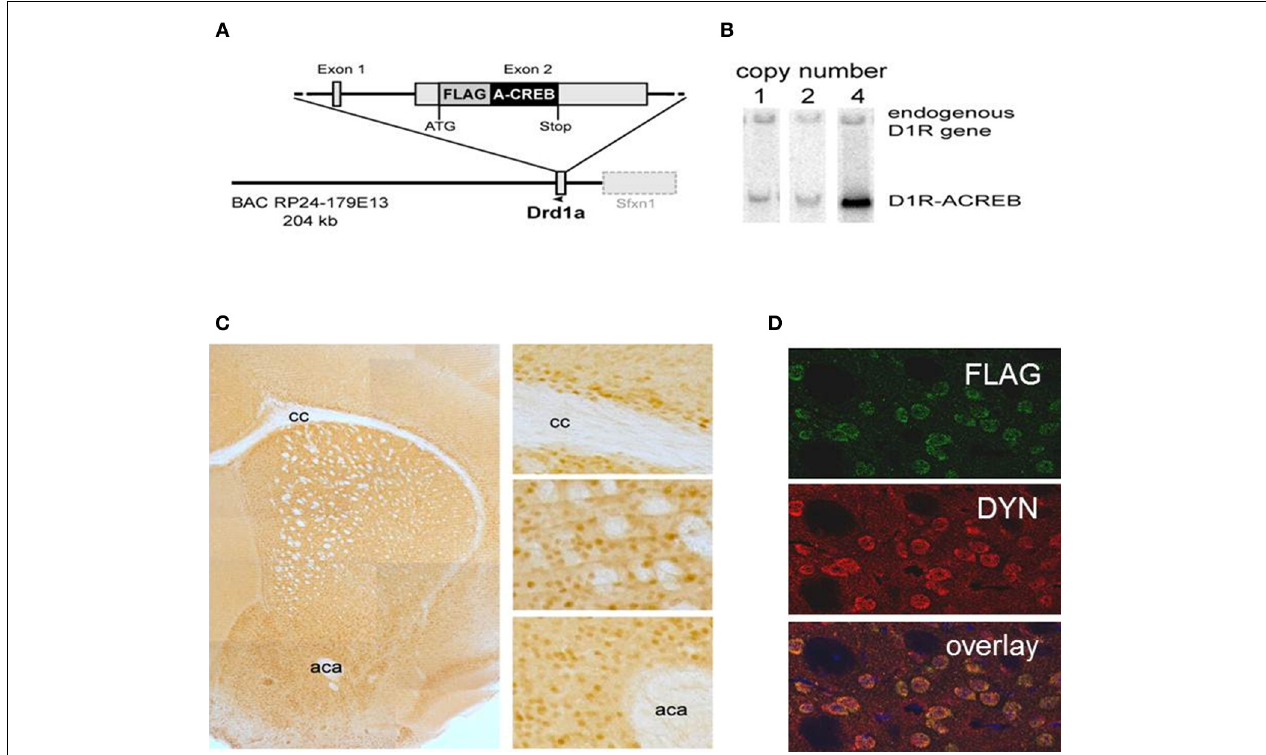
FIGURE 1 | Cell-type specificity of the A-CREB transgene. (A) Design of the transgene D1R-A-CREB BAC construct. This construct was inserted after the translational start of the gene encoding the dopamine D1 receptor in a BAC. (B) Southern blot of 3 founder lines of D1R-A-CREB with 1, 2, and 4 copies of the transgene. (C) Expression of the transgene in D1R-A-CREB mice in coronal brain sections. Brain slides were incubated with anti-Flag antibodies and a peroxidase-conjugated